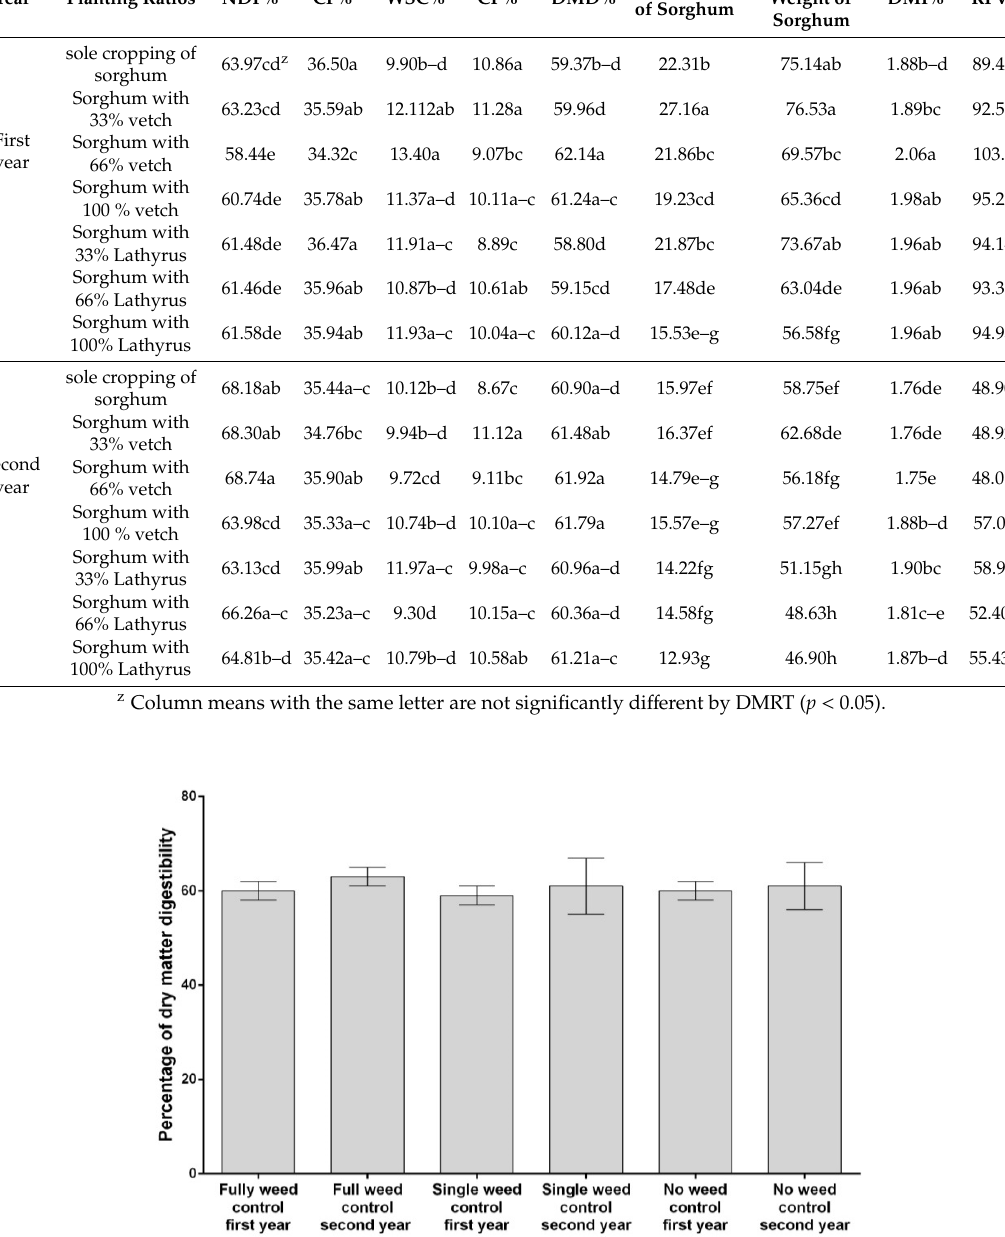
Figure 1. Mean comparison by year of the effect of weed management on percentage of digestible dry matter. All measurements were performed in triplicate. Data are shown as the mean ± standard deviation. There were no significant differences.